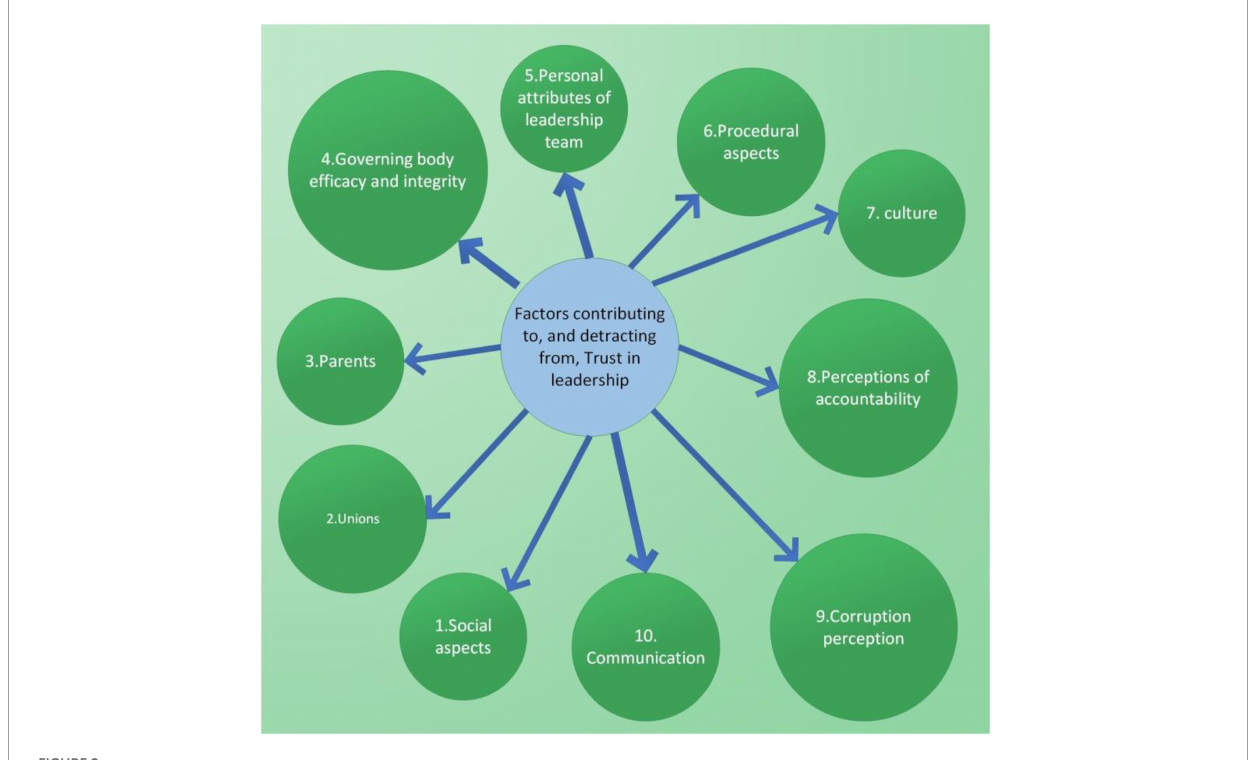
FIGURE2 Themes relating to perceptions of trust in